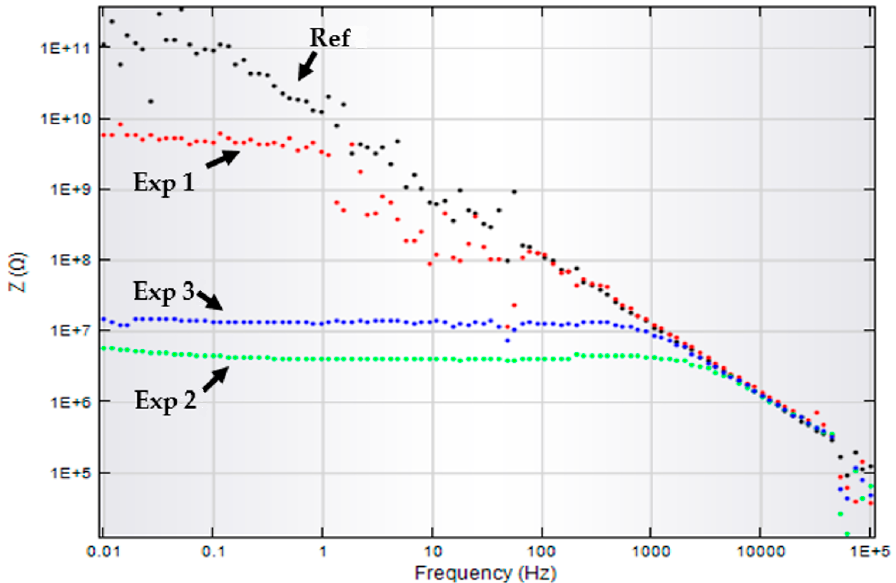
Figure 9. Bode plot for virgin and aged samples. The impedance decreased in experiments 1 and 2 due to the chain scission, which occurred due to CO 2 exposure and saturated seawater in the autoclave, as shown in Figure 9. The aged material loses its strength as compared to the virgin sample. Initially, the virgin sample indicates very high resistance (10 11 ) at low frequency. The impedance values higher than 10 7 illustrate excellent surface protection of the sample [33]. The half semicircle at high frequency was ascribed to coating protection performance. The coating impedance decreases when the material degrades in the autoclave, and the capacitance loop can be seen in the Nyquist plot. Coating impedance starts decreasing from 10 11 to 10 9 then 10 6 ohms.cm − 2 for samples aged at 60 and 75 ◦ C temperatures. Coating resistance (R c ) decreases while the capacitance increased, as shown in the Nyquist plot. However, the resistance gets higher at 90 ◦ C, and this behavior also shows us the loss in capacitance. Z w represents the Warburg impedance, which resulted from the diffusion of ions from the electrolyte to the electrode interface. The modeling of EIS data was carried out using the NOVA software, an equivalent electrical circuits (EEC) were used to analyze the degradation of coatings quantitatively. Nyquist plots and the EEC circuits have been shown in Figures 10 and 11, while their respective circuit element values are shown in Table